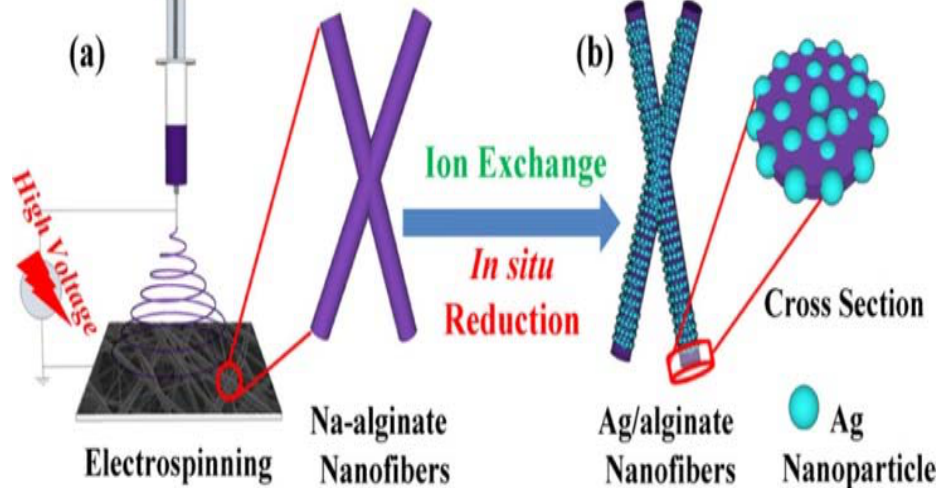
Figure 7. Schematic illustration of Ag–alginate nanofibers fabrication. ( a ) Electrospinning sodium alginate, and ( b ) ion exchange and in situ reduction processes for AgNPs/alginate nanofibers. Reprinted with permission from [85].